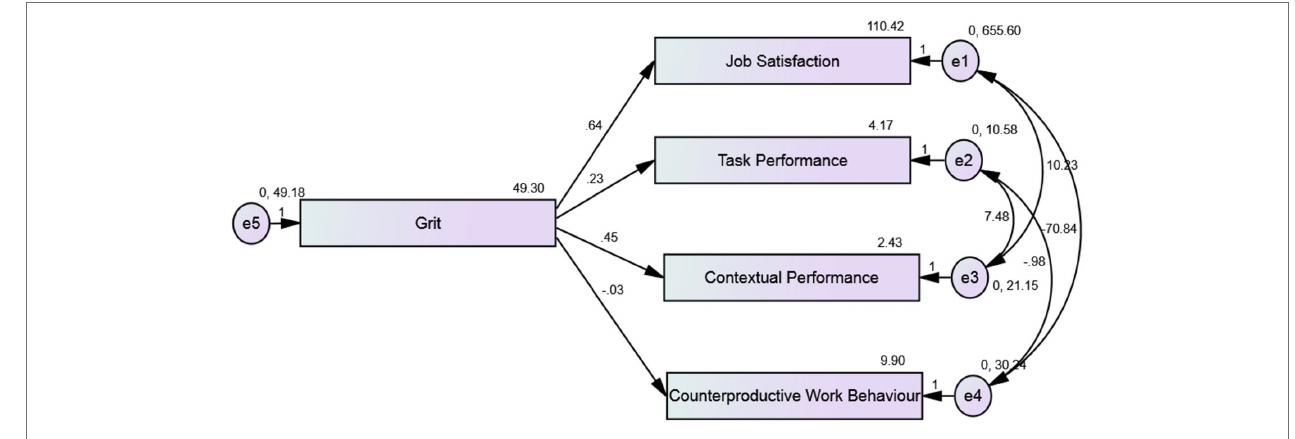
FIGURE 2 | Confirmatory factor analysis of consequences of